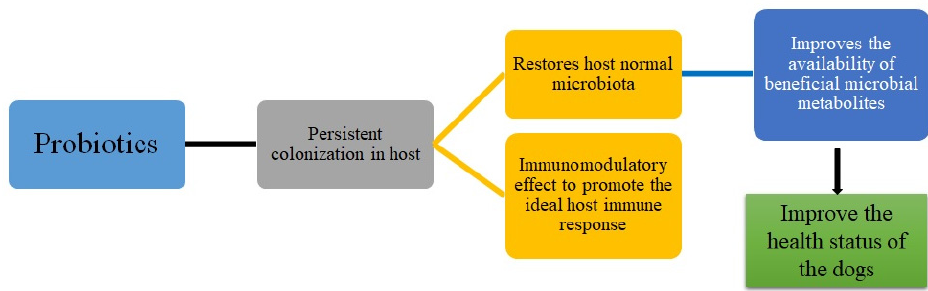
Figure 1. Possible mechanism of probiotic action on improving the health status of dogs.